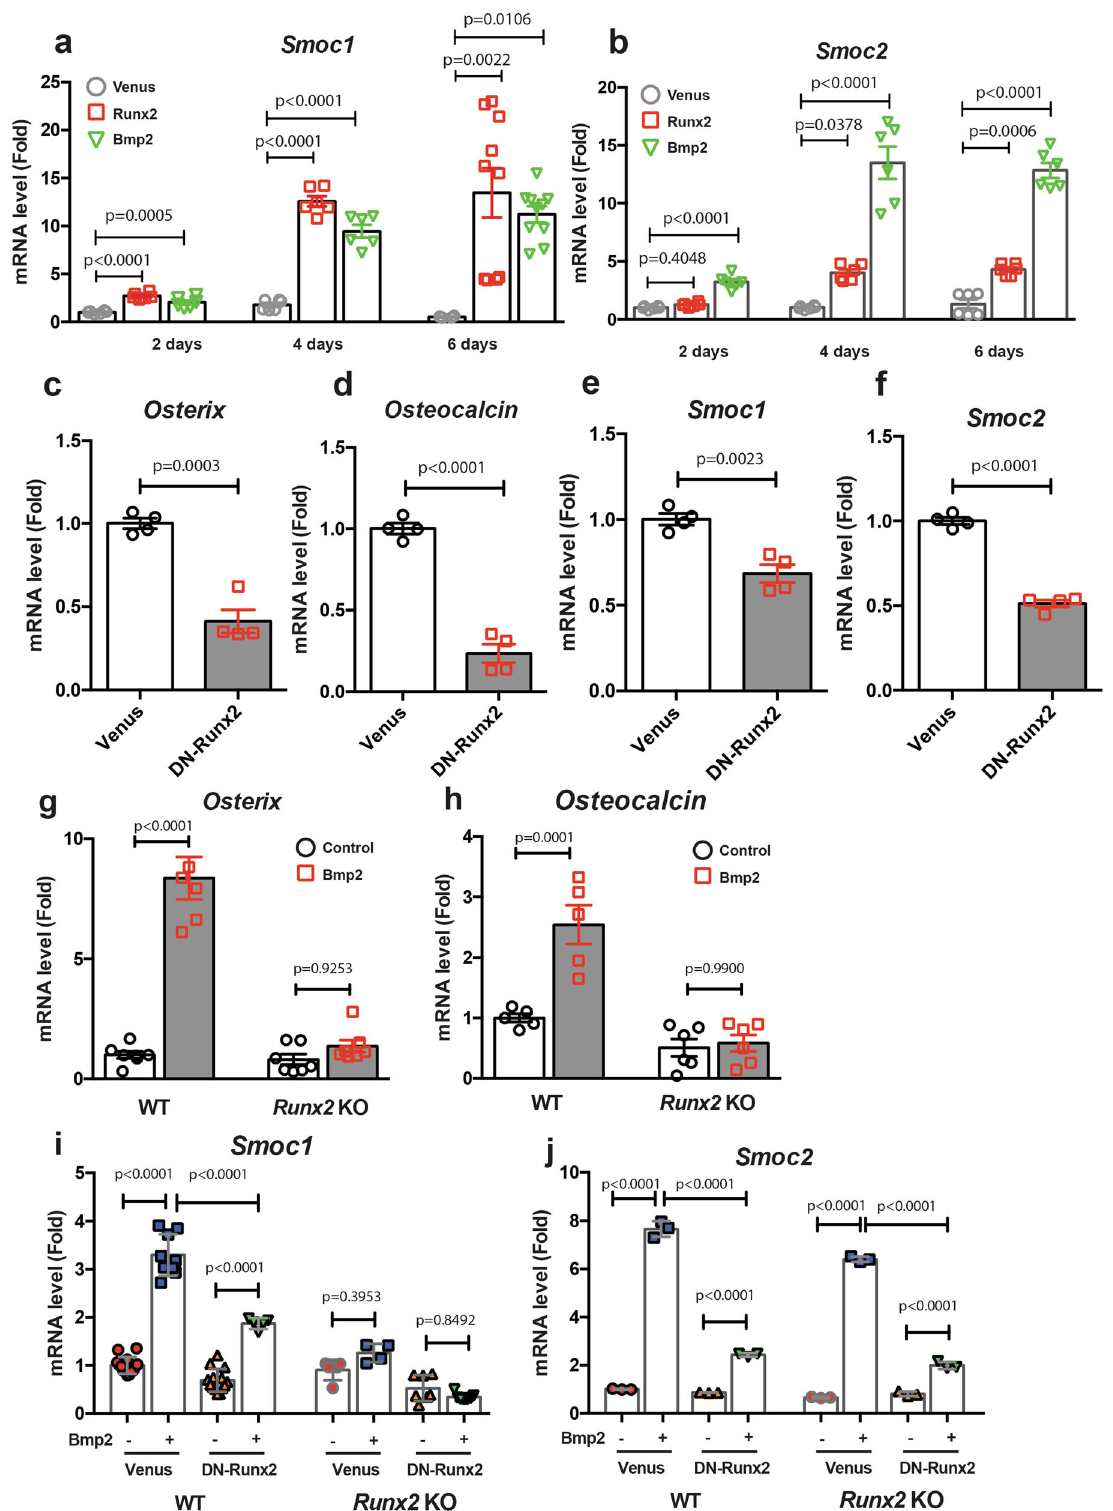
we fi rst generated Smoc1 fl ox mice and mated these with CAG-Cre transgenic mice. Following the generation of Smoc1 heterozygous de fi cient mice, we established Smoc1 KO mice by mating the het- erozygous mice (Supplementary Fig. 6). Okada et al. previously reported that Smoc1 homozygous mutant mice displayed a phe- notype of ocular dysplasia, limb malformation, and fi bula loss 24 . These Smoc1 KO mice were viable at postnatal day 0 (P0) but